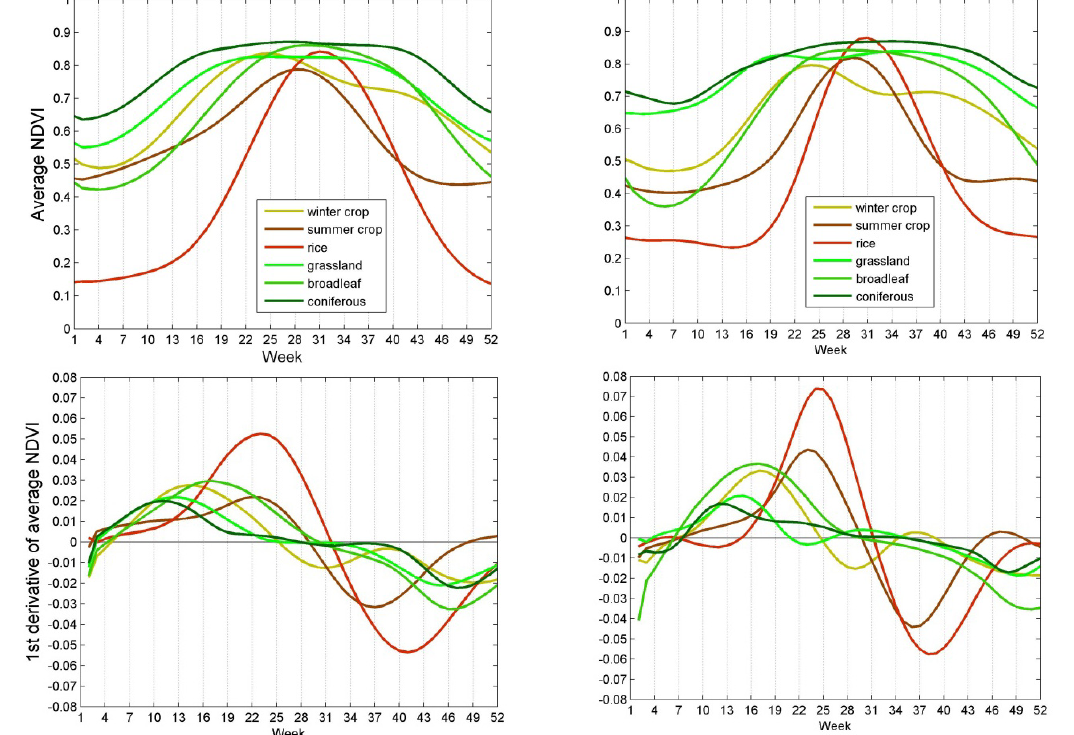
Figure 2. NDVI profiles ( top ) and first derivatives ( bottom ) for individual pixels from GIMMS ( left ) and MODIS ( right ). Example pixels were selected to represent different land cover types. Curves were obtained by averaging the respective NDVI of sample locations over the period of 2002–2011.